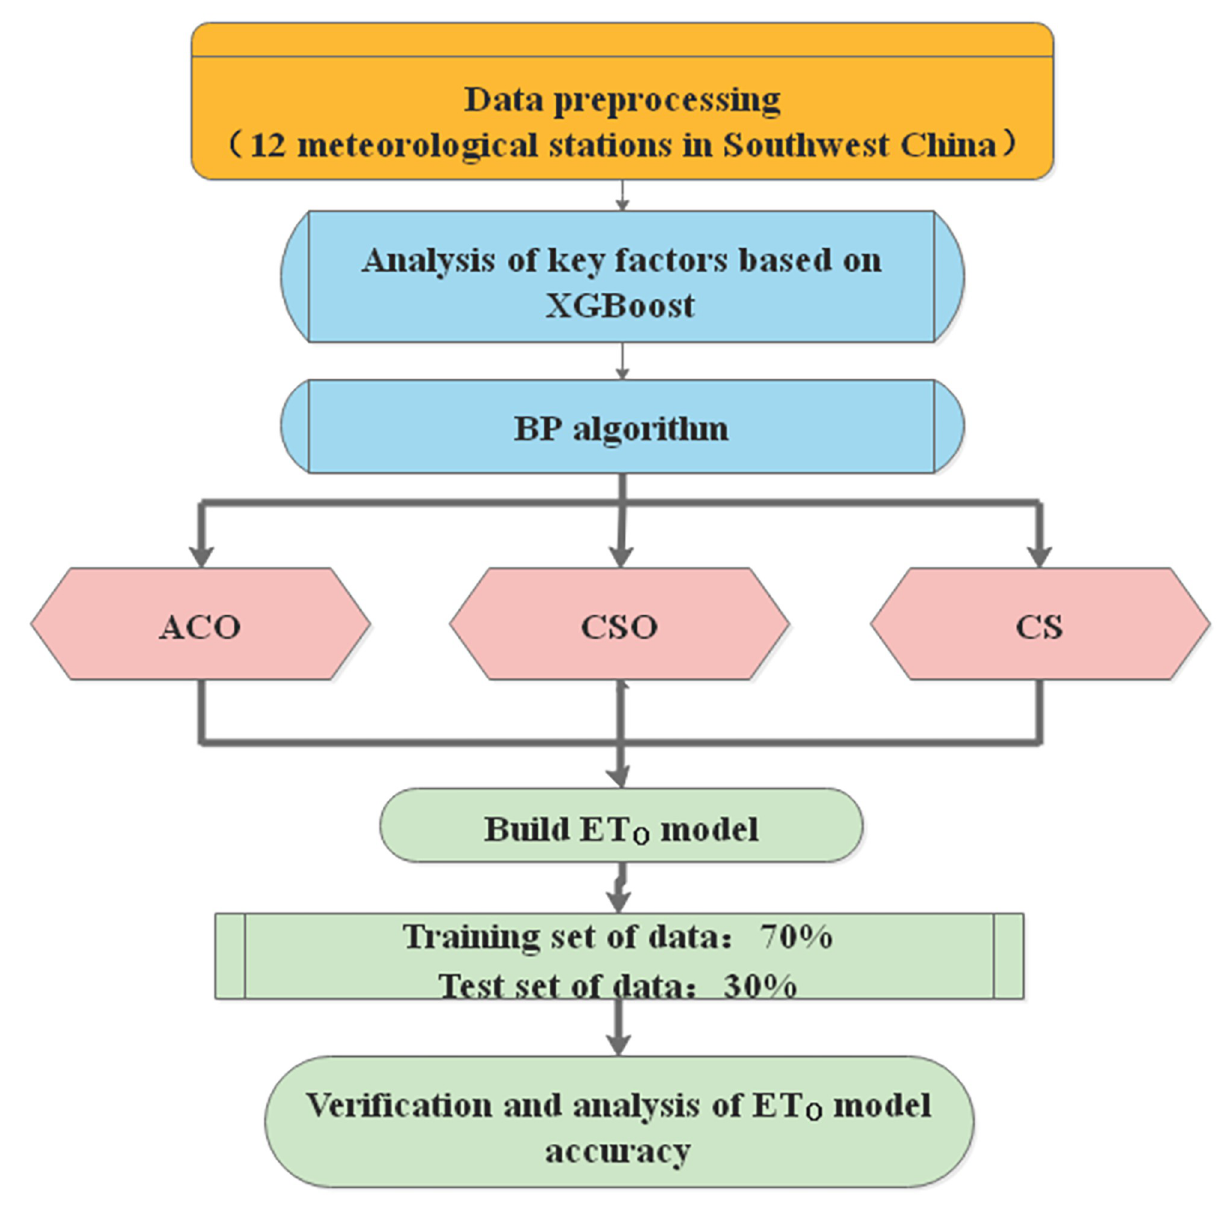
Fig 2. The technical process of this